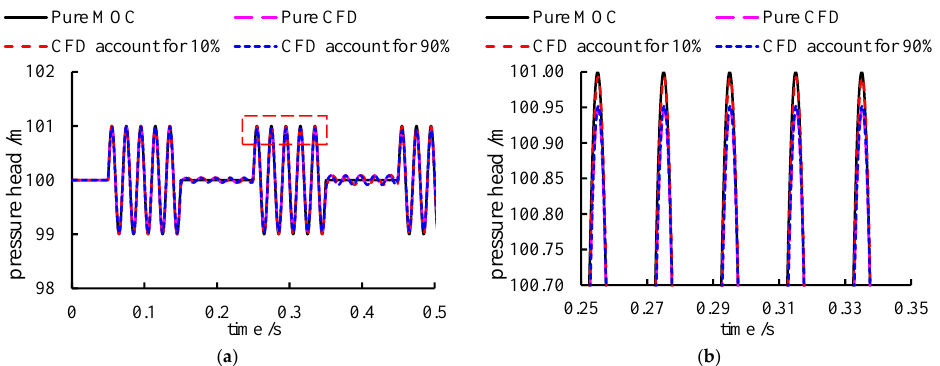
Figure 6. Pressure head variation at the center of the entire system. ( a ) Overview ( b ) zoom-up view.